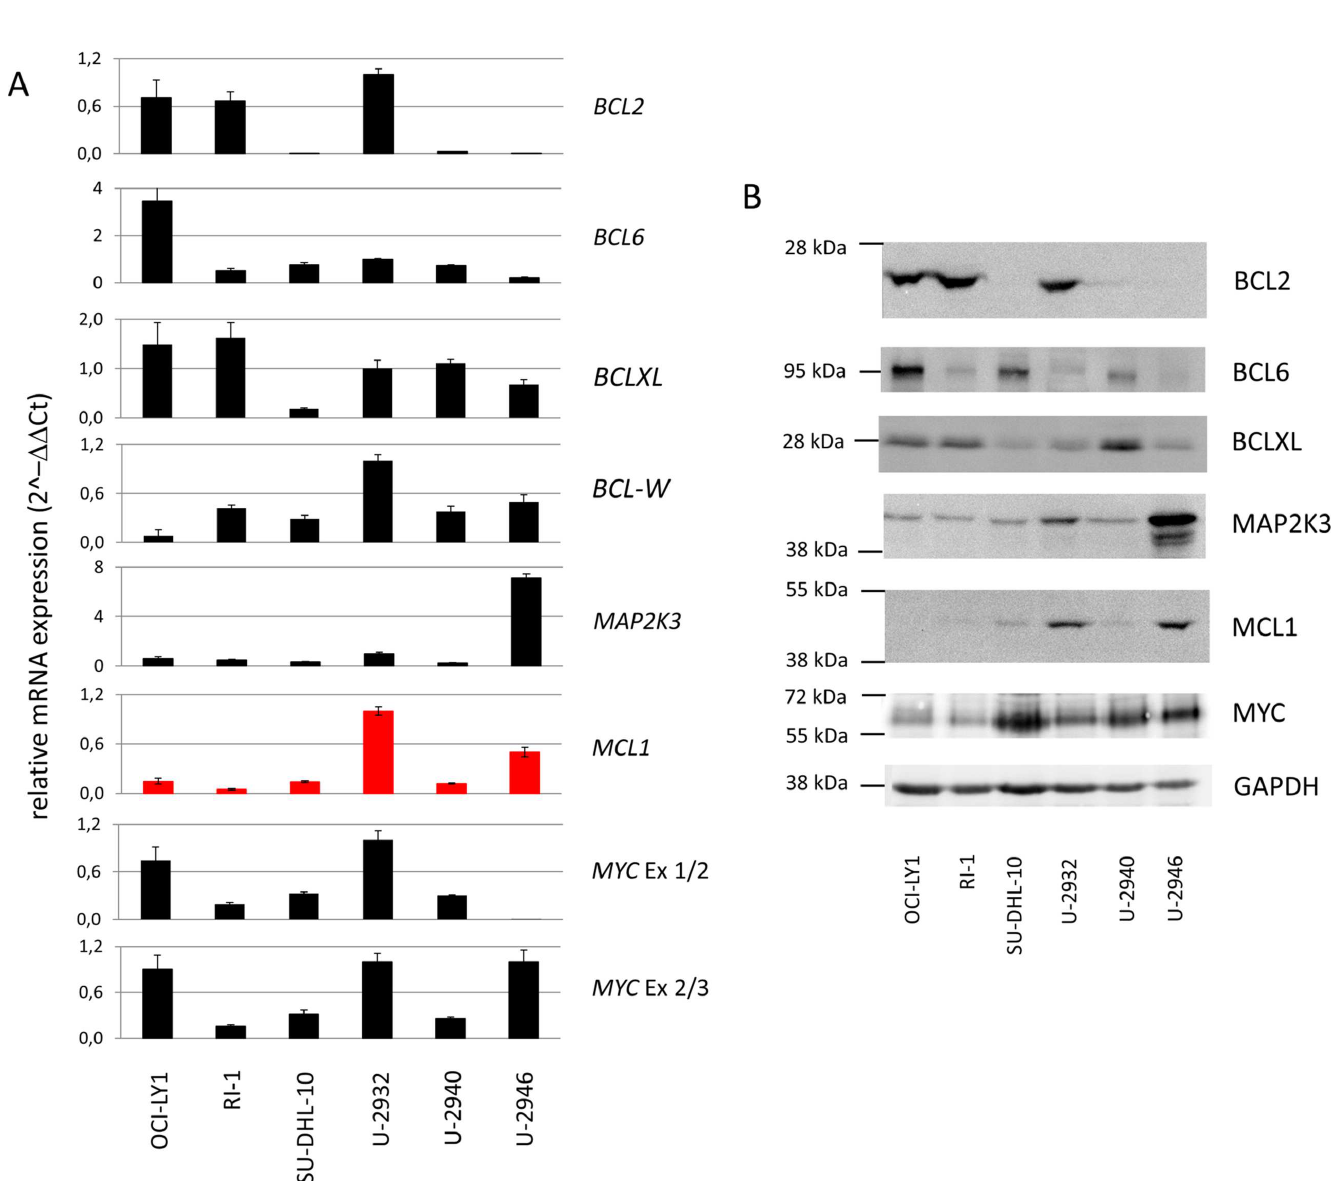
Fig 3. Expression of BCL2, BCL6, BCLXL, MAP2K3, MCL1, and MYC in DLBCL cell lines. A) qRT-PCR and B) Western blot analysiswas performed to assess the expressionof oncogenesin U-2946 and other DLBCL cell lines. The bars in A) indicatemeans with standard deviation(n = 3). The ct values for BCL-W in qRT-PCR were high ( > 30) in all cell lines tested explainingabsenceof specific bands in Western blot analysis(not shown). Note the high- level expressionof MCL1 (red) in cell lines U-2946and